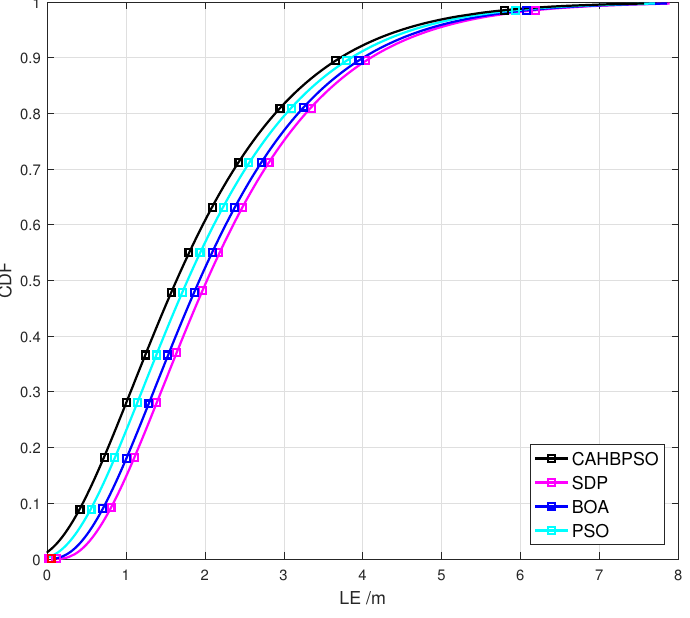
Figure 9. CDFs of passive target localization error of the considered algorithms for the first simulation